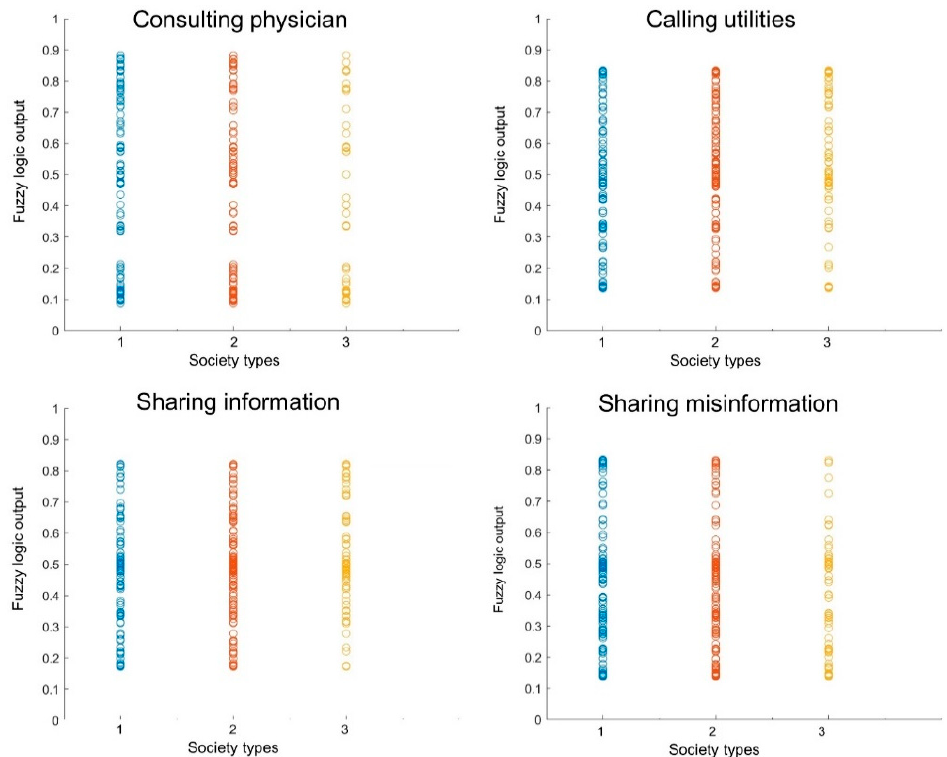
Figure 9. Scatter plot of the fuzzy logic system output in scenario two for the three different society types and the four different possibly taken actions.